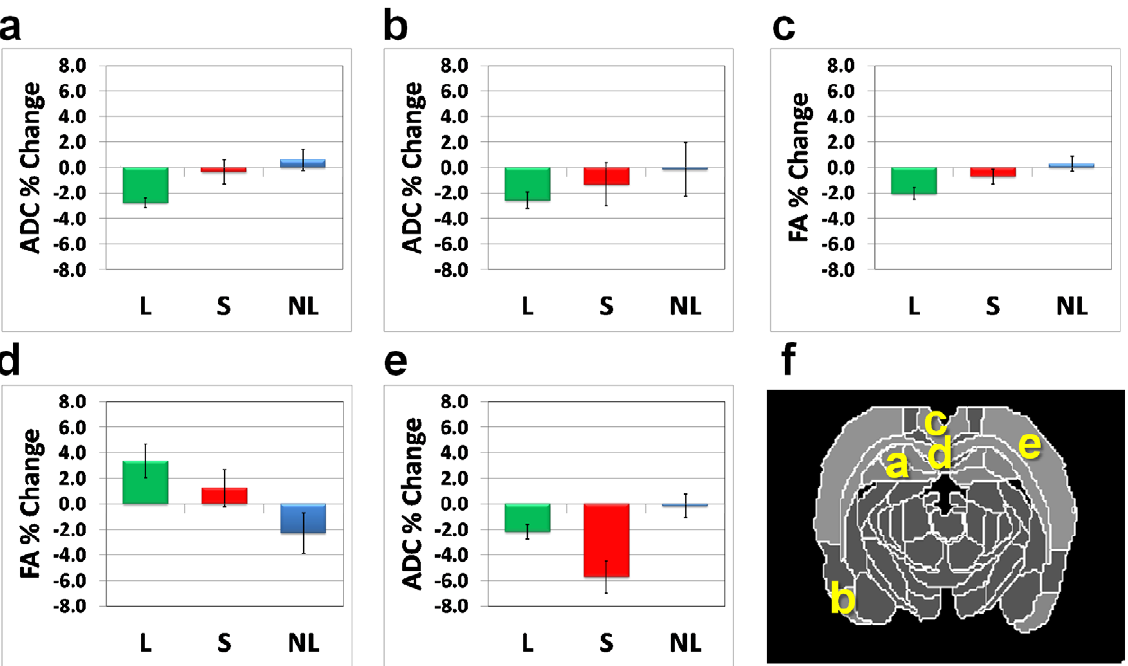
Figure 2. Regional analysis of the parametric interaction maps. Type 1 of interaction, i.e., regions that exhibit significant changes in the learning group (L) only were identified in ADC in the dentate gyrus ( a ) and piriform cortex ( b ) and FA in the cingulate cortex ( c ) and corpus callosum ( d ). Type 2 of interaction, i.e., regions that exhibit significant changes in the swimming-only (S) group and to lesser extent in the learning (L) group was found in the S1/S2 cortex ( e ). ( f ) Brain atlas diagram with the abovementioned regions indicated.